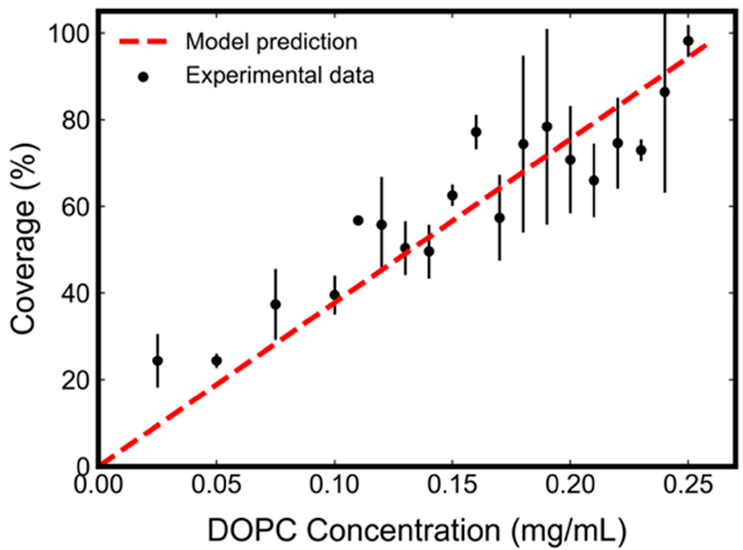
Figure 2. Effect of initial DOPC lipid concentration on SLB formation by the SALB method.